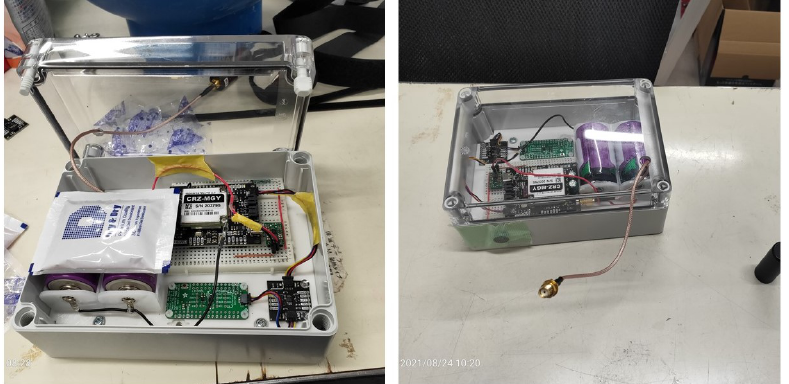
Figure A1. Illustrations of the instrument v2021 electronics components enclosed in a water-resistant Takachi